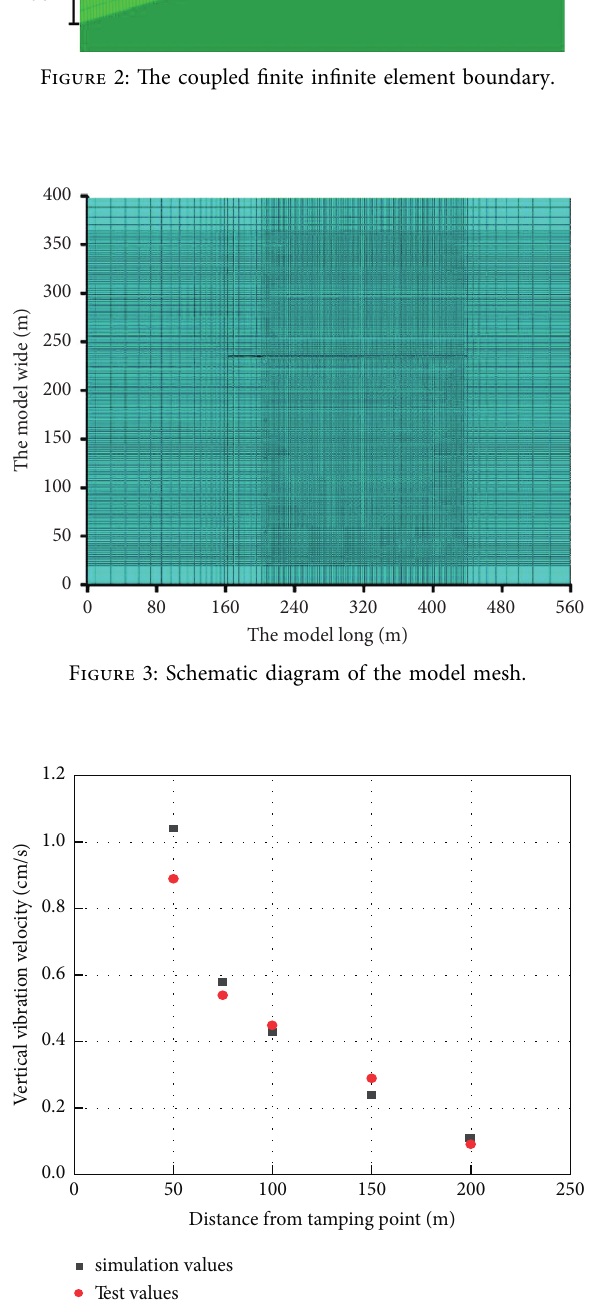
Figure 4: Comparison of the trial compaction test values and the numerical simulation